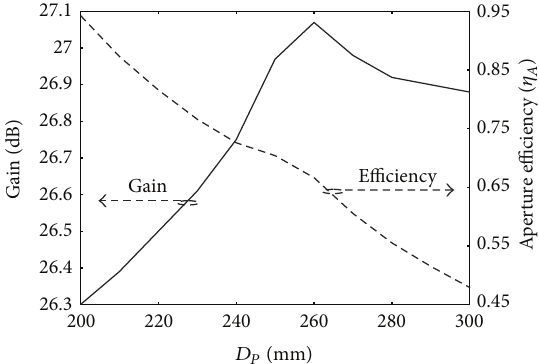
Figure 3: 8 × 8 array with two-layer dielectric cover: gain and effi- ciency as a function of 𝐷 𝑃 .